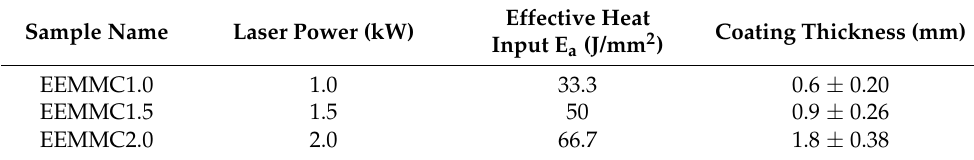
Table 2. Cladding conditions and average thickness of the coating layer of the